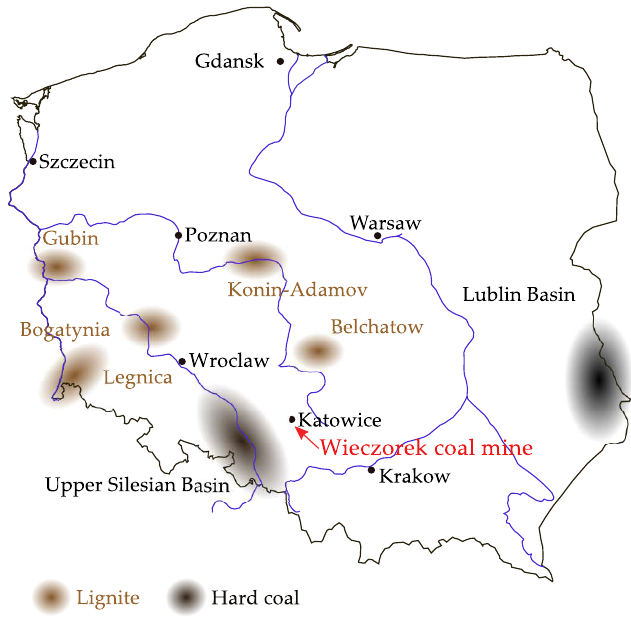
Figure 2. Location of the selected study area (Wiezcorek coal mine) in Poland. Modified from the European Association for Coal and Lignite (EURACOAL)